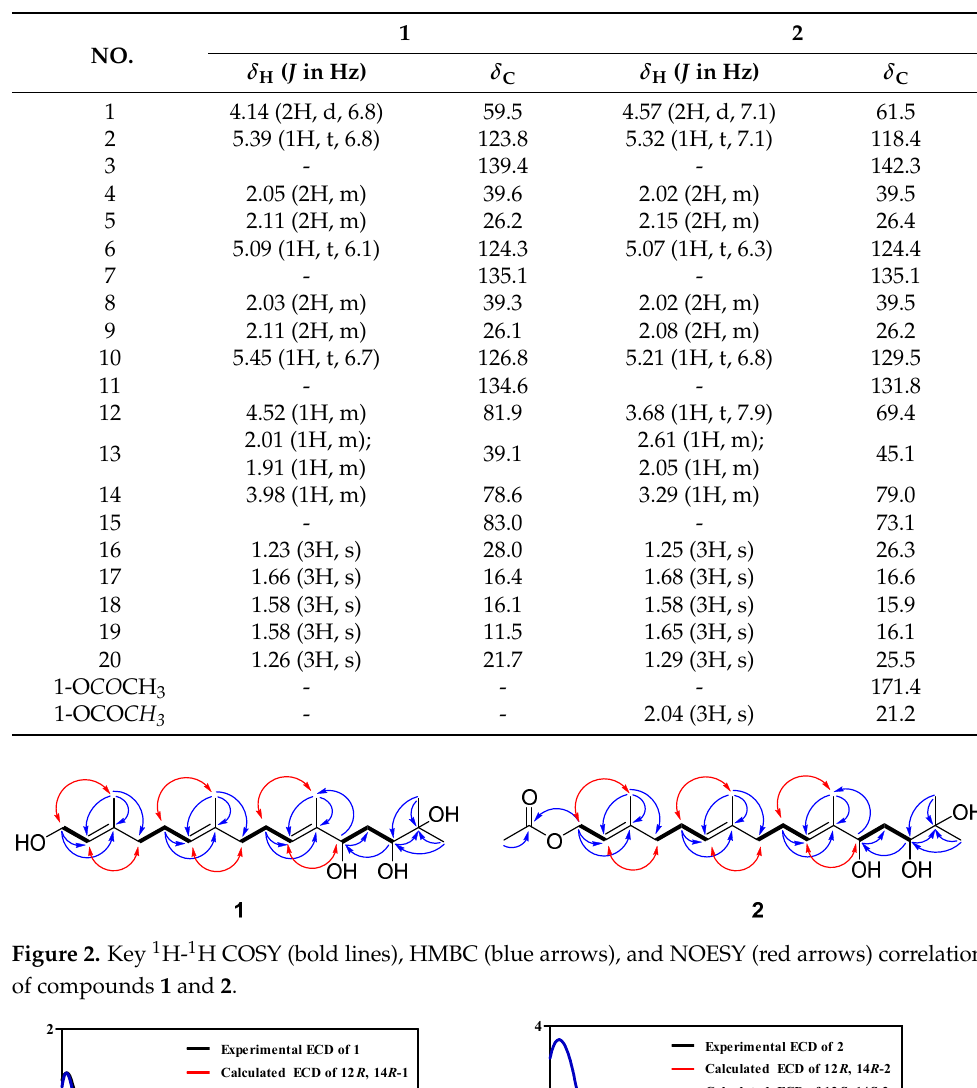
Table 1. 1 H-NMR (600 MHz, CDCl 3 ) and 13 C-NMR (150 MHz, CDCl 3 ) chemical shifts of compounds 1 and 2 ( δ in ppm).